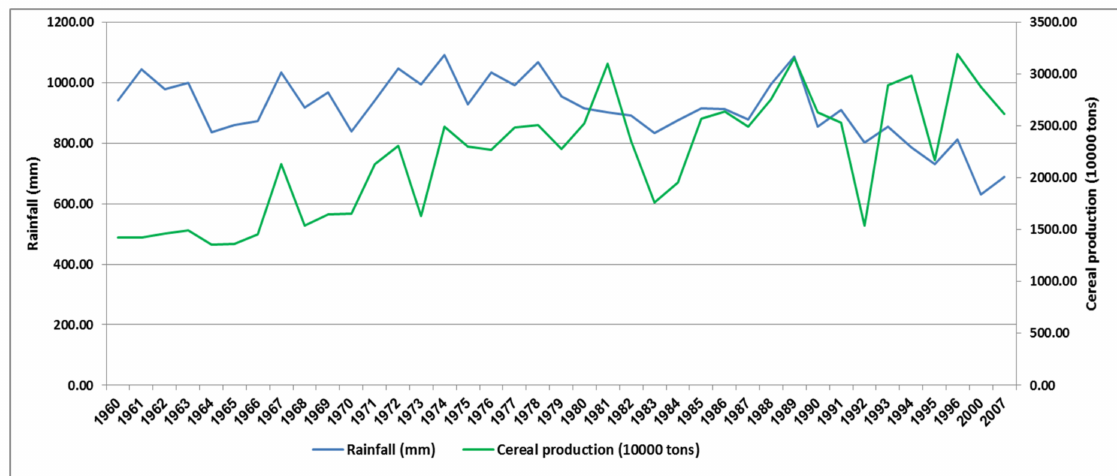
Figure 7. Correlation between rainfall variability and cereal production in southern Arica over time as influenced by increased aridity.